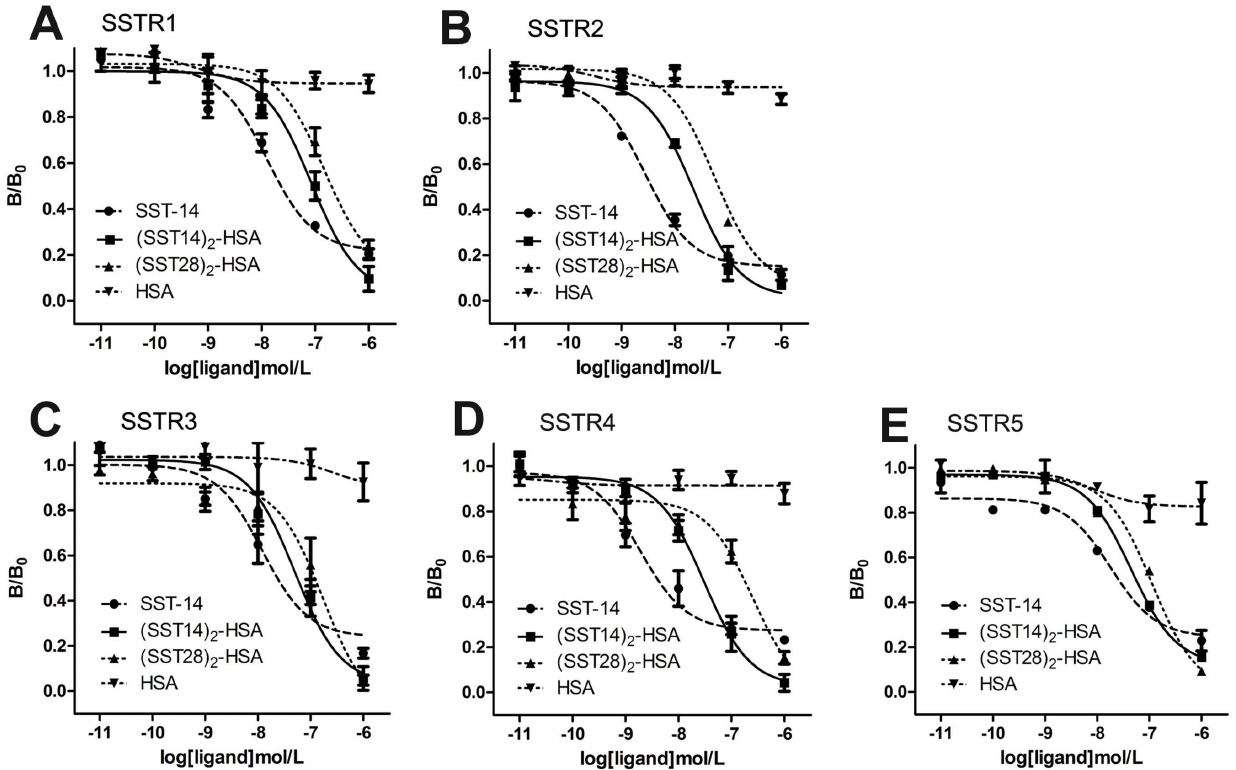
Figure 2. Binding affinity of somatstatin-HSA fusion proteins for somatostatin receptors. HEK 293 cells stably expressing SSTR1, SSTR2, SSTR3, SSTR4 or SSTR5 were incubated with 50 pM 125 I-Tyr 1 -somatostatin in the absence or presence of increasing concentrations of unlabeled ligand for 1 hour at 25 u C. After washing to remove nonspecific binding, the amount of bound radioligand was quantitated in a c -counter. Data are presented as the mean of three independent experiments. S.E. values were smaller than 15%.